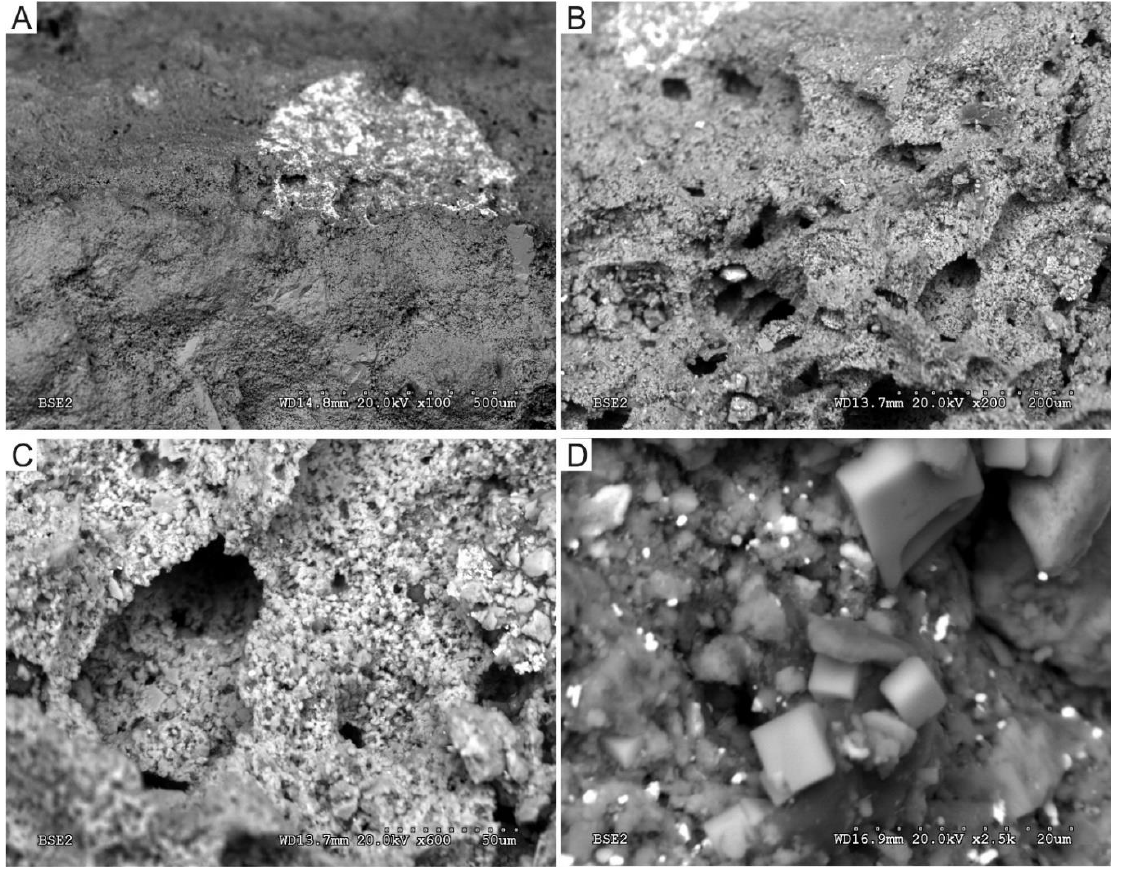
Figure 5. SEM micrographs showing the limestone surface of the Cross of the Inquisition. ( A ) General view of limestone surface showing zones with preferential Fe-staining (mottling). ( B , C ) Detail of the high porosity (interparticle and intercrystalline pores) at the sample’s surface. ( D ) Detail of small idiomorphic halite (NaCl) crystals grown in interparticle porosity.